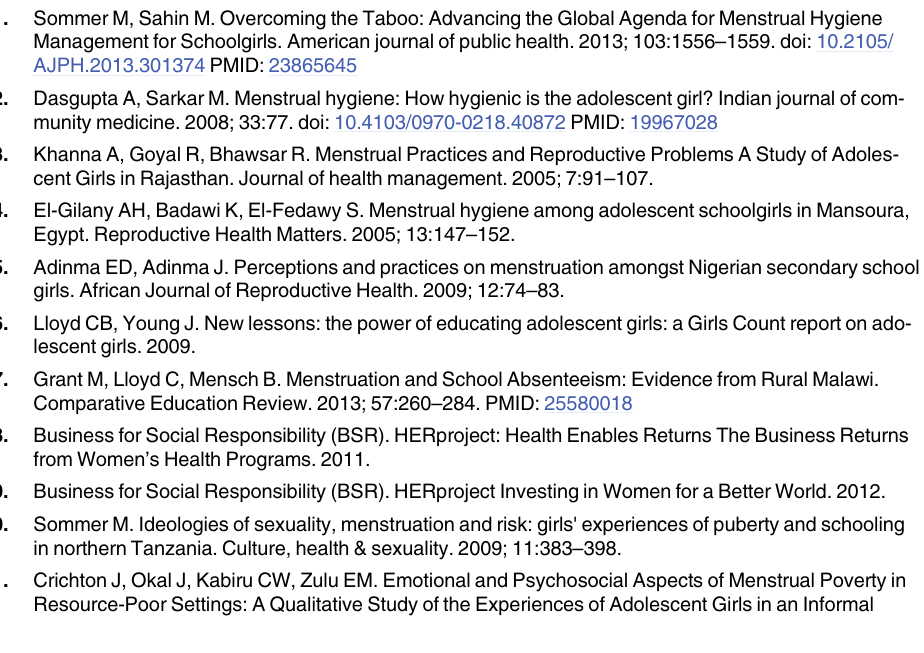
S1 Table. Characteristics of ongoing studies. S2 Table. Study risk of bias assessments. S3 Table. Full-text studies excluded with reasons. S4 Table. PRISMA